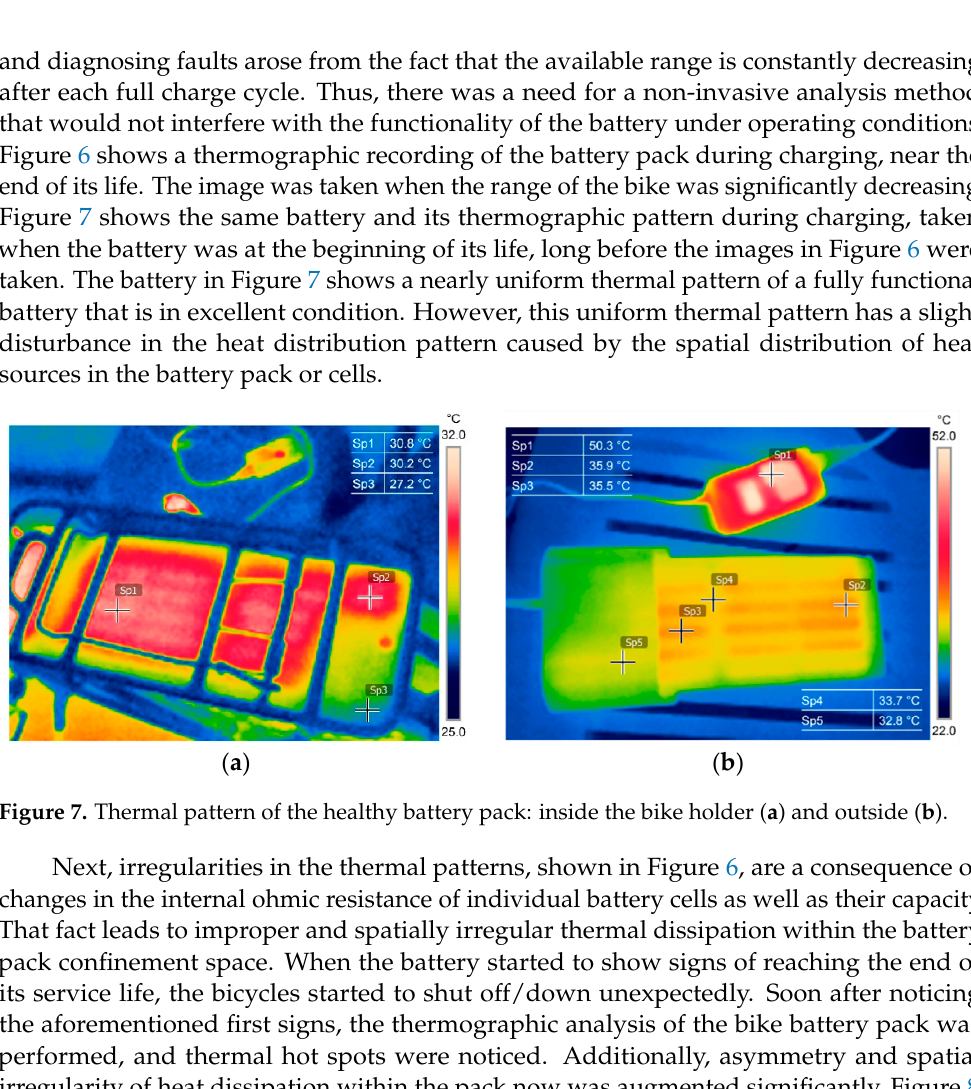
Figure 6. Functional battery pack charging thermal patterns near the end of its life, ( a ) top view ( b ) bottom.